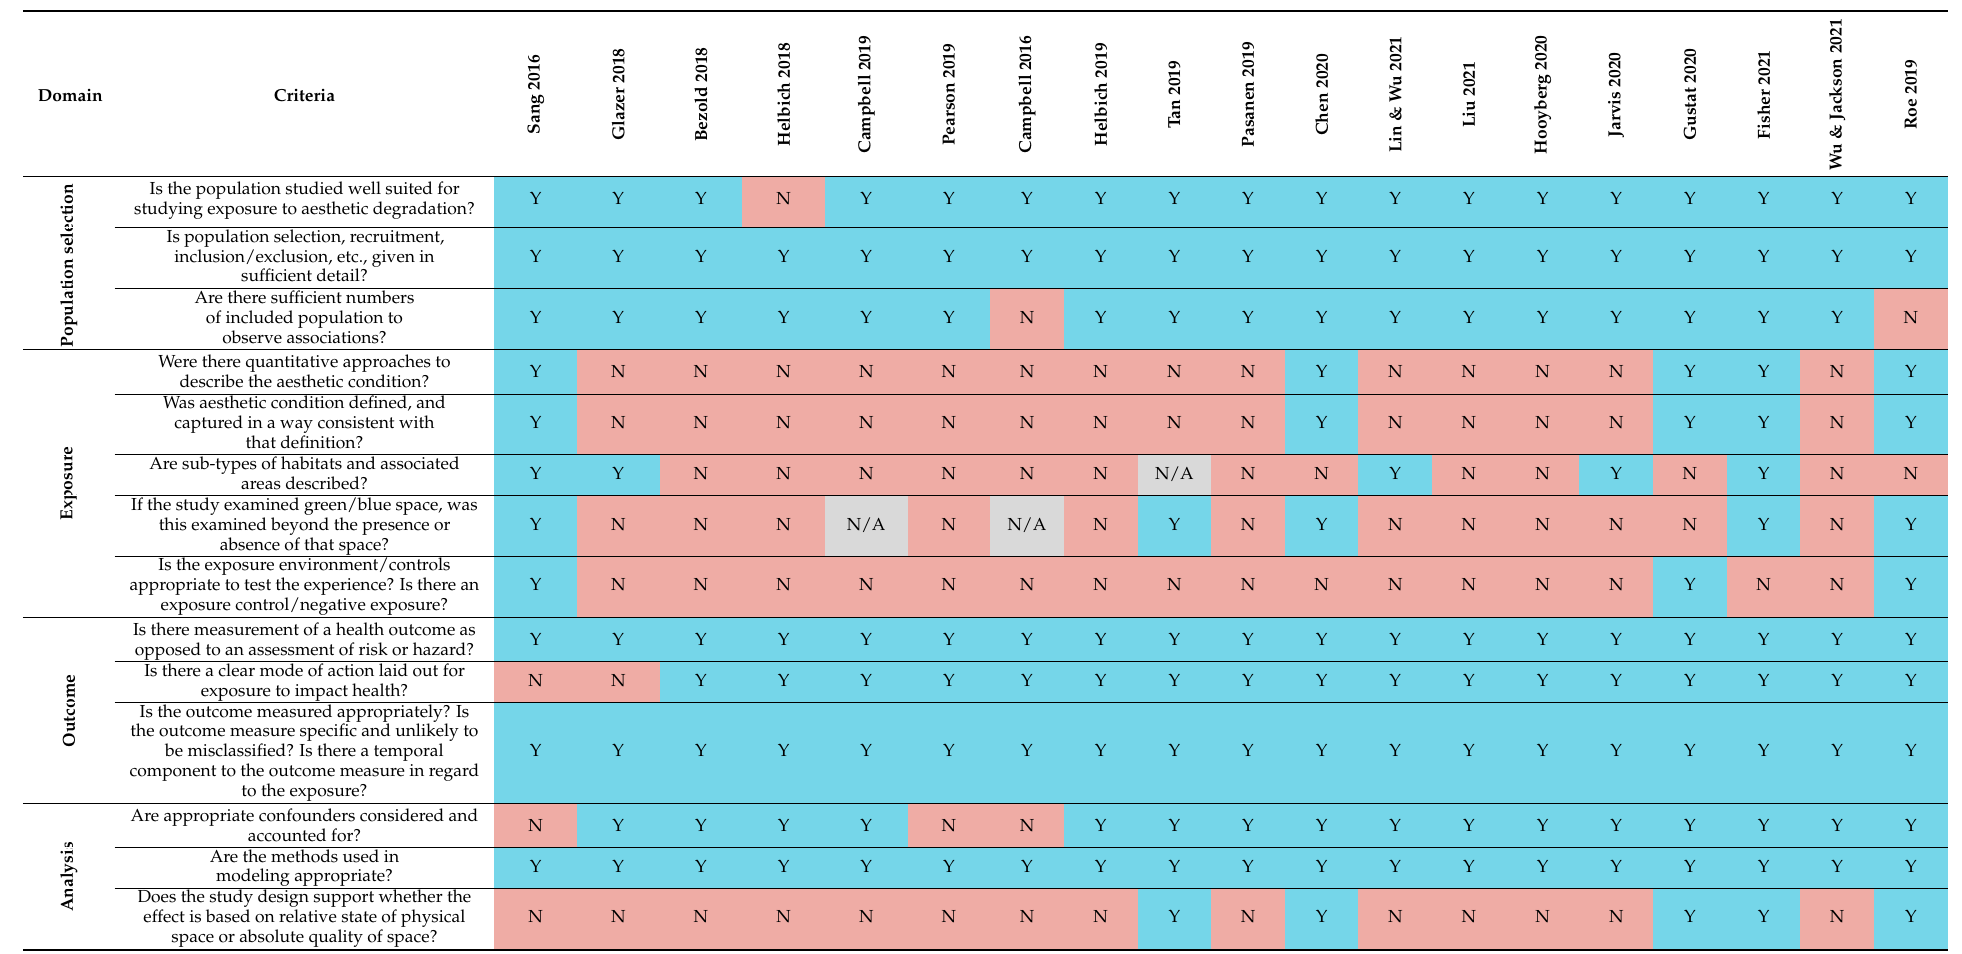
Table 2. Study Evaluation